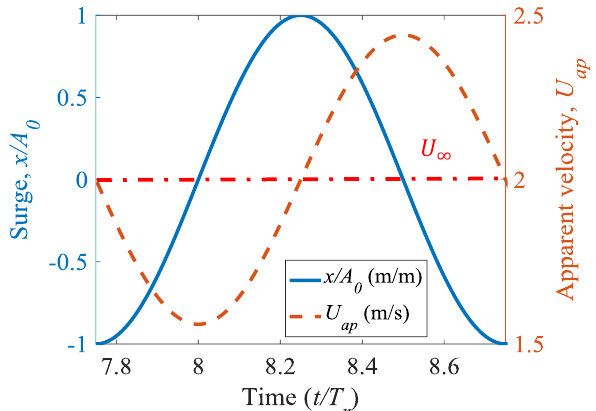
Fig. 3. Normalized surge and apparent velocity time histories for a turbine surging at surge amplitude and frequency of 𝐴 0 = 0.5m and 𝜔 0 = 0.88 rad/s, respectively. The inflow velocity 𝑈 ∞ = 2 m/s.